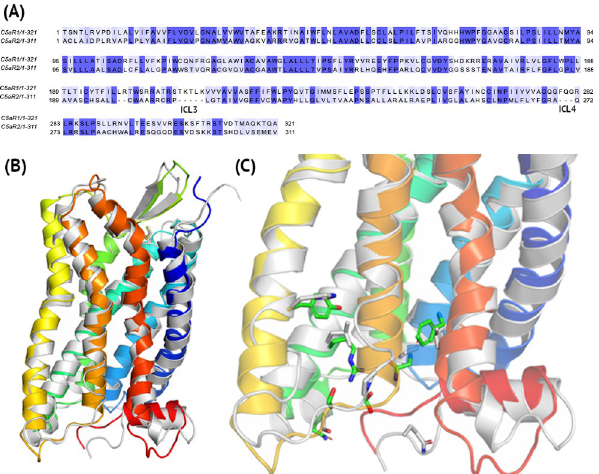
Fig 6. The differences between C5aR1 and C5aR2. (A)–Pairwise sequence alignment with ICL3 and ICL4 loops indicated with 5 and 3-residue deletions in C5aR2. (B) A comparison of the crystal structure of inactive C5aR1 (5O9H, blue-to-red) and a homology model of C5aR2 based on this crystal structure (grey). (D) Amino acid substitutions in the G α binding region. Here, extracellular 1–29 residues in the N-terminus of C5aR1 and 1–27 residues in the N- terminus of C5aR2 were truncated relative to the sequences deposited in Uniprot (accession numbers P21730 and Q9P296, respectively).